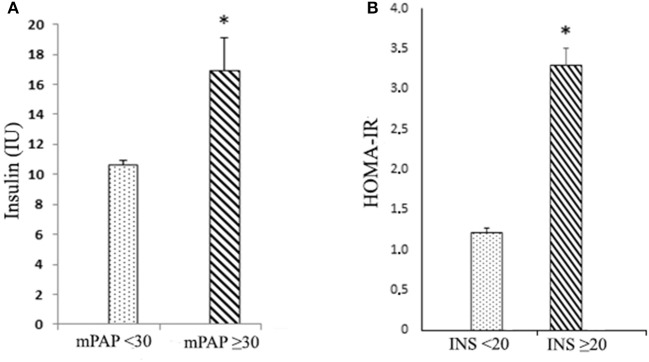
Comparison between insulin, mPAP, and HOMA-IR (A) insulin (INS; IU) according to mean pulmonary artery pressure values (mPAP; mmHg); cut-off point < ≥30 mmHg; and (B) homeostatic model assessment (HOMA-IR; Index) according to insulin values: cut-off point < ≥20 IU. Values are means (X¯)±SE (standard error); *p < 0.01.